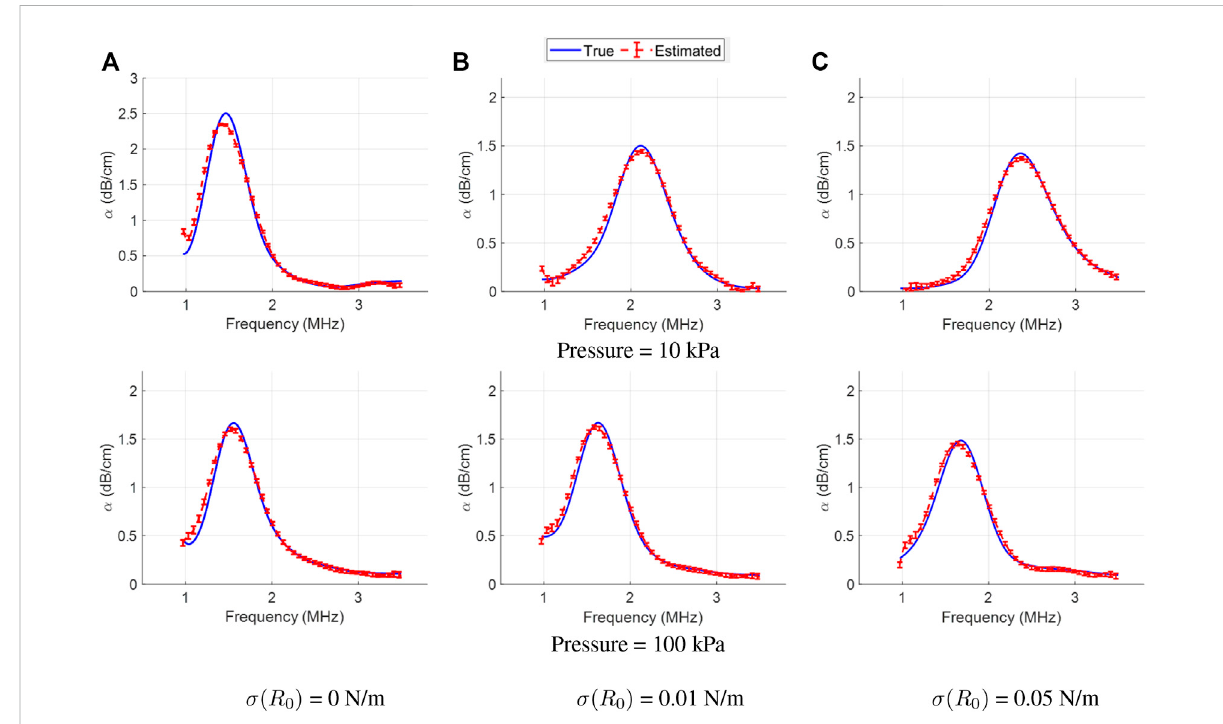
FIGURE 8 True (solid lines) and LLS estimated (dashed lines) attenuation spectra for the monodisperse bubbles, for varying acoustic pressure (row-wise) Column-wise, the plots are for three different initial surface tension values: (A) σ ( R 0 ) = 0 N/m, (B) σ ( R 0 ) = 0.01 N/m, and (C) σ ( R 0 ) = 0.05 N/m. The estimated curve is the mean computed over the estimator ’ s results on 10 different datasets, with errorbars denoting the standard deviation.